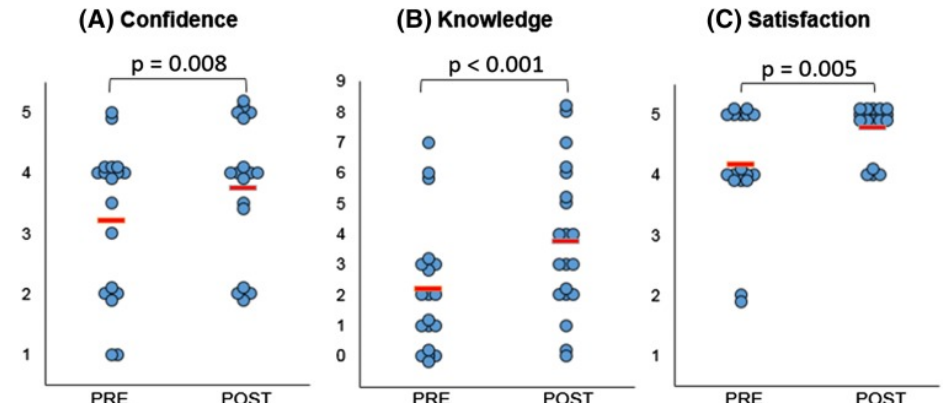
Figure 8. Statistically significant differences were noted in confidence ( A ), knowledge ( B ) and satisfaction ( C ) amongst participants, comparing responses before (“Pre”) and after (“Post”) their medical consultation. ( A ): One refers to not at all confident, and five to very confident. ( B ): Each point represents a point in knowledge, as marked based on the correct name of primary diagnosis, correctly identified keywords and correct use of diagrams. ( C ): One indicates very dissatisfied, and five is very satisfied. The red lines indicate average score. Reprinted with permission under the open access from Biglino et al. [72].